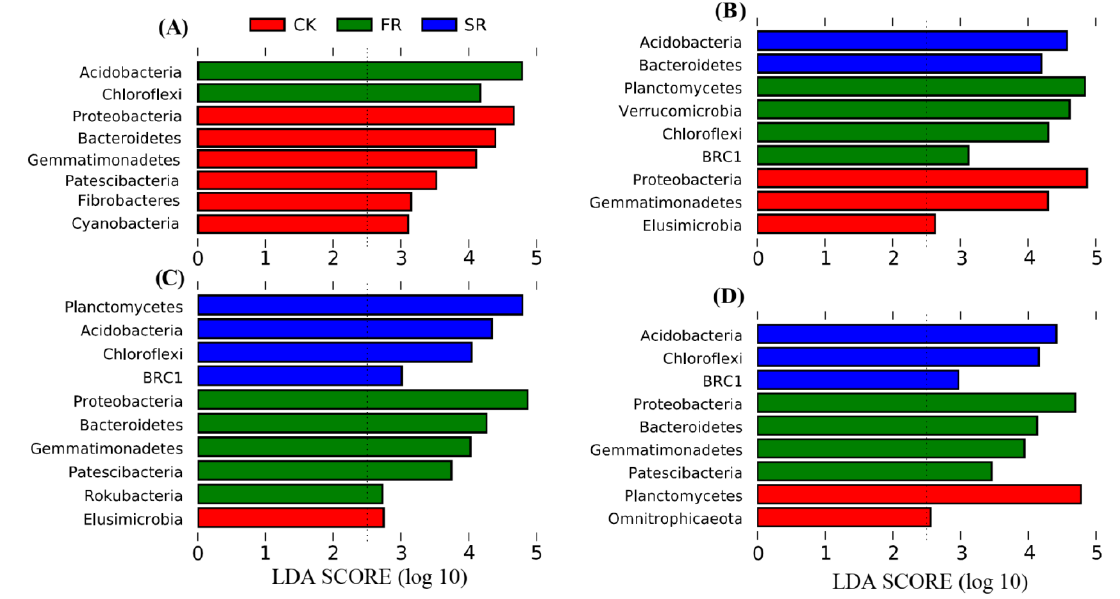
Figure 5. Linear discriminant analysis (LDA) histogram scores computed for the bacterial phyla response to straw application: ( A ) 10 days after sowing, ( B ) 20 days after sowing, ( C ) 40 days after sowing and ( D ) 60 days after sowing. CK, no straw application; FR, one-year straw application; SR, two-year straw application. The threshold employed for the logarithmic LDA score of the discriminative features was 2.0.